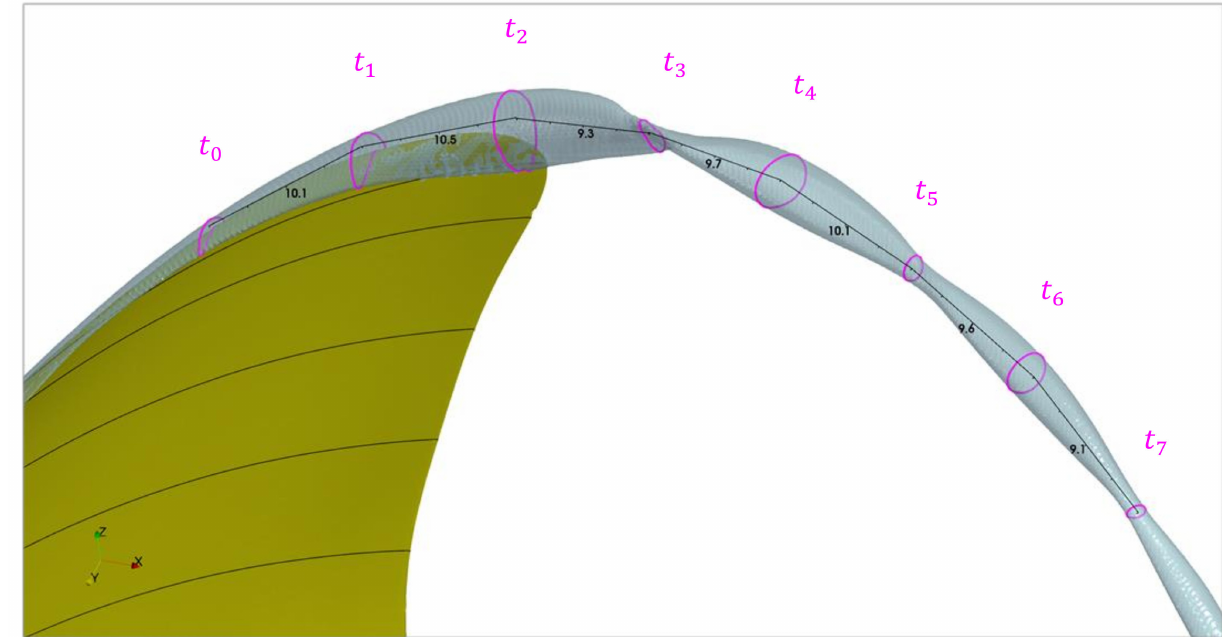
Figure 5. PPTC’11. Tip vortex cavitation isosurface with investigated stations and normalized arc length approximation along